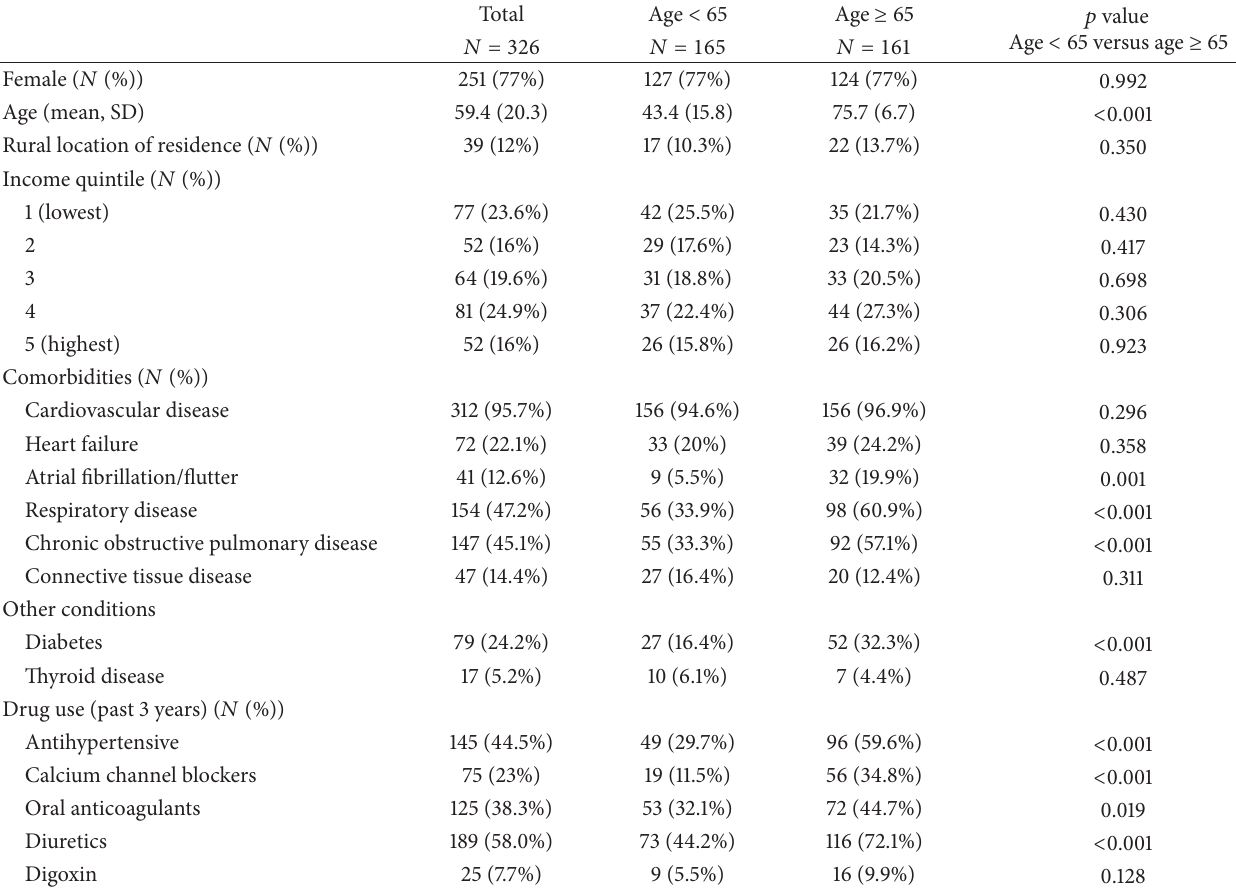
Table 1: Baseline characteristics and demographics of PAH cases in Ontario as of April 1,